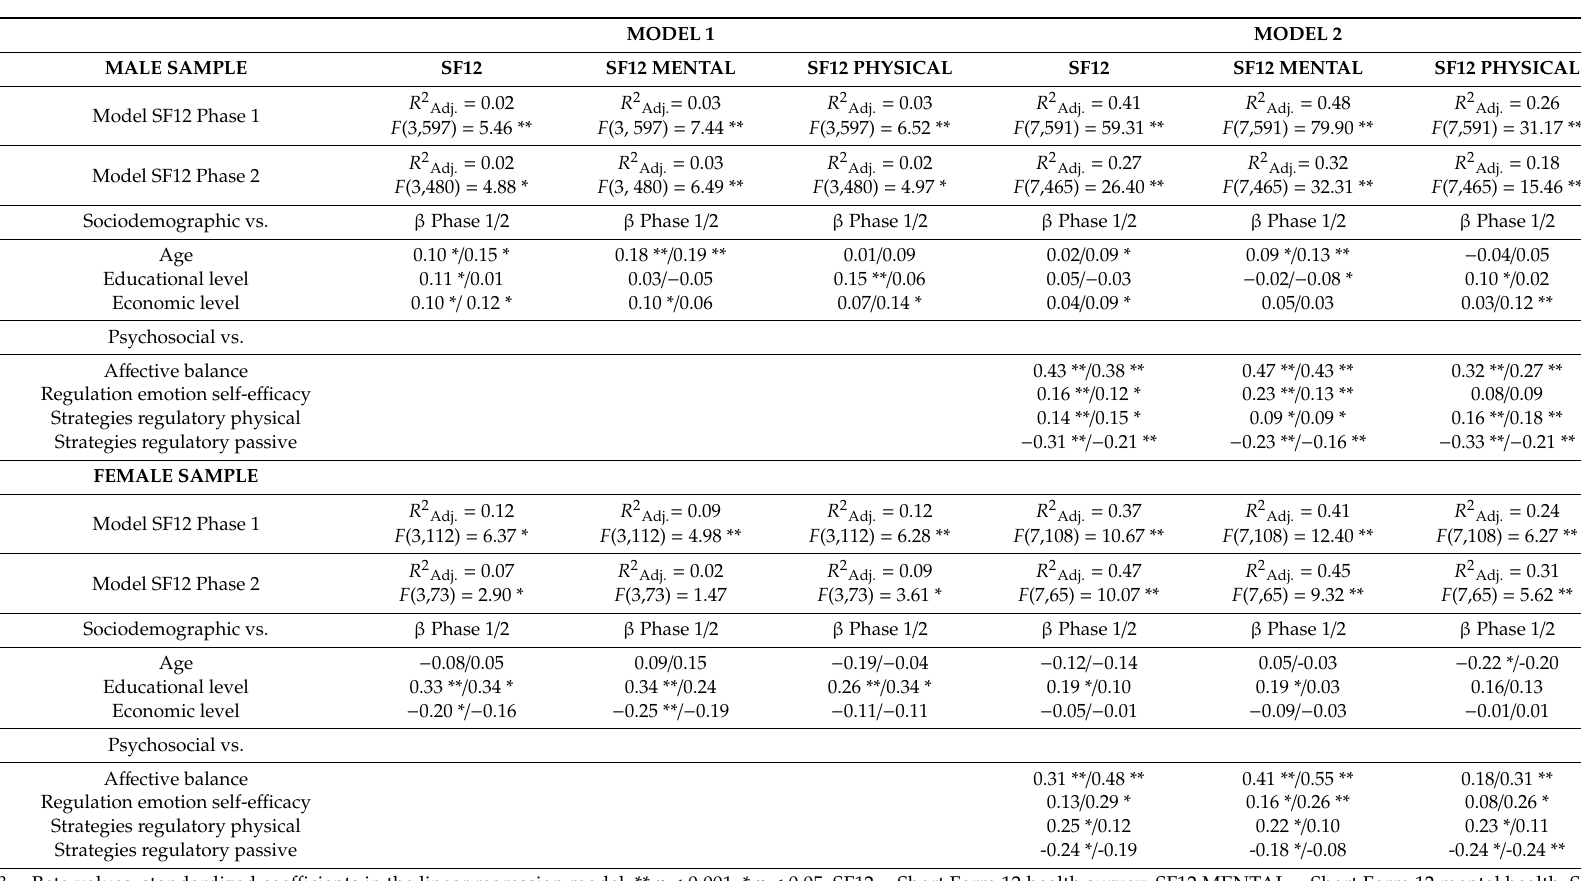
Table 5. Predictive variables of perceived health in phase 1 and phase 2 in the male and female samples. In model 1, sociodemographic variables are inserted as predictors of global, mental, and physical health in phase 1 and phase 2. In model 2, sociodemographic and psychological variables are inserted as predictors of global, mental, and physical health in phase 1 and phase